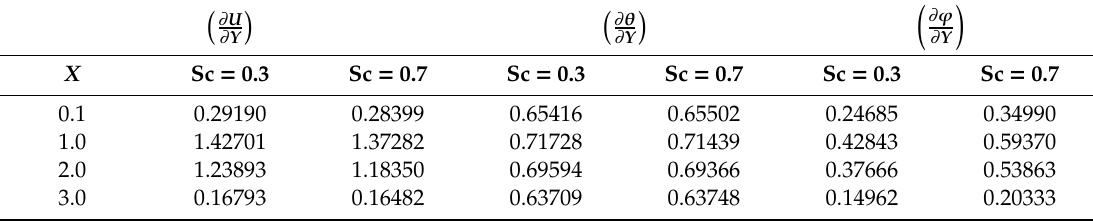
Table 4. Physical e ff ects on quantities ∂ U ∂ are